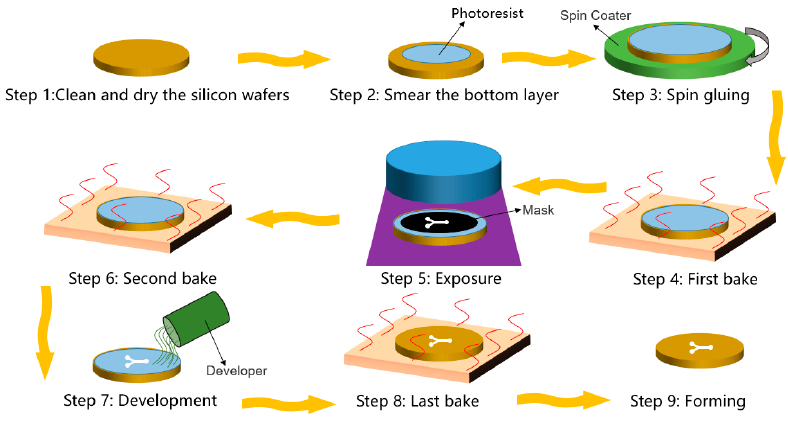
Figure 3. General steps of photolithography.